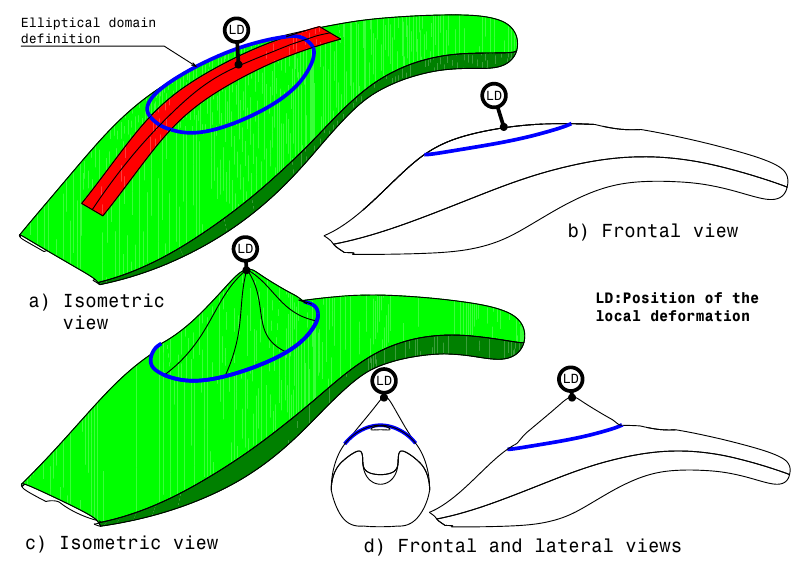
Figure 10. Local